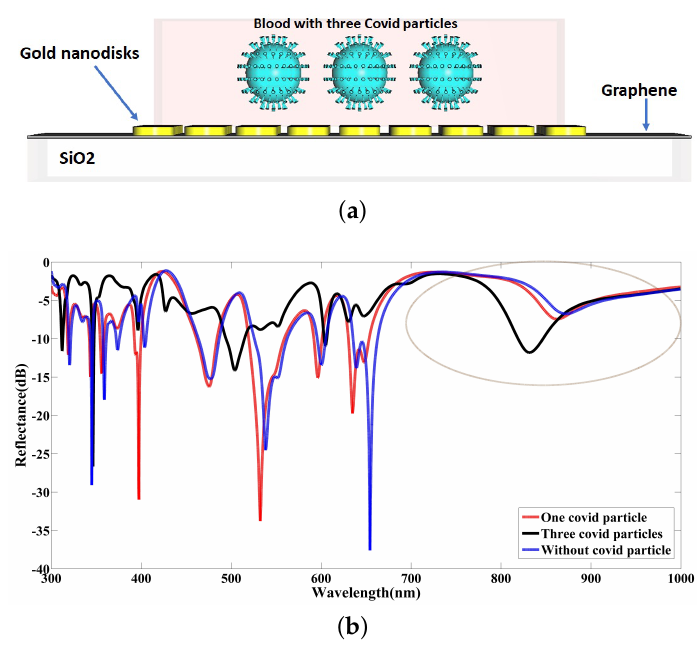
Figure 12. ( a ) A graphical screen of the proposed nanosensor under testing blood samples with a specific COVID-19 density; ( b ) the contrast of the reflected spectra for different blood samples with and without COVID-19